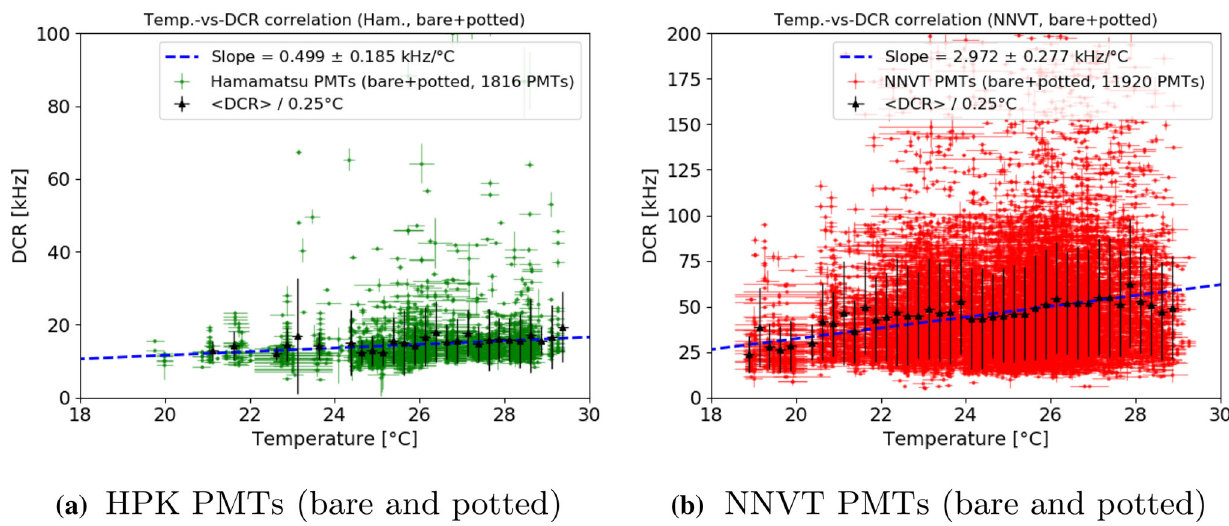
Fig. 22 Observed correlation between air temperature in the container and measured DCR of a large sub-sample of PMTs. The black dots indicate the mean and STD of all DCR measurements within the corresponding 0 . 25 ◦ C slice